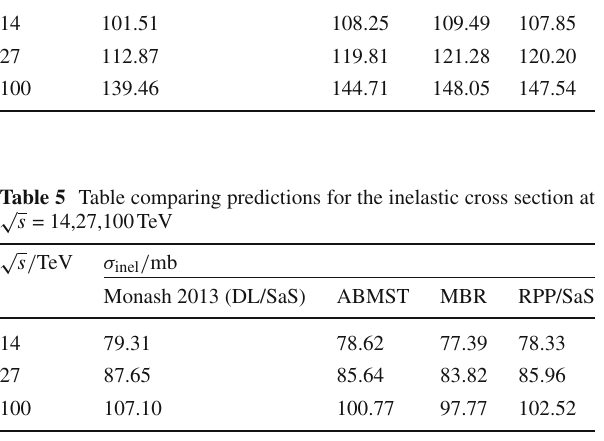
Table 4 Table comparing predictions for the total cross section at